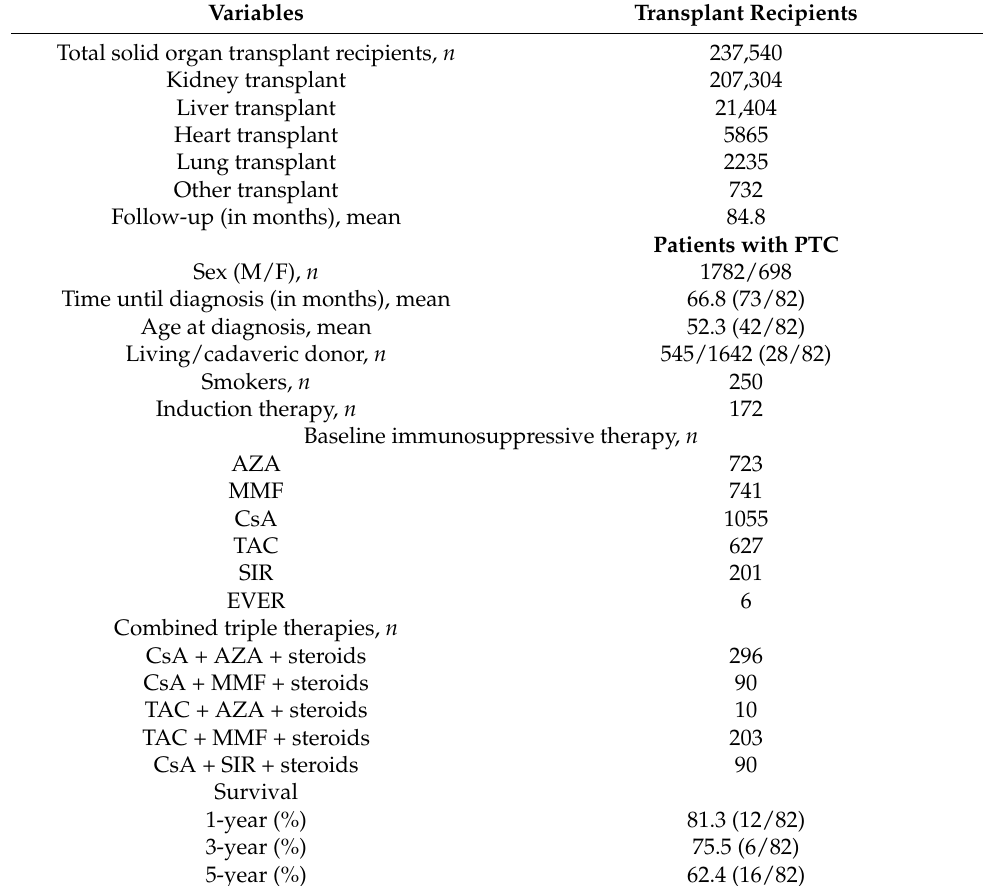
Table 2. Baseline characteristics of transplant